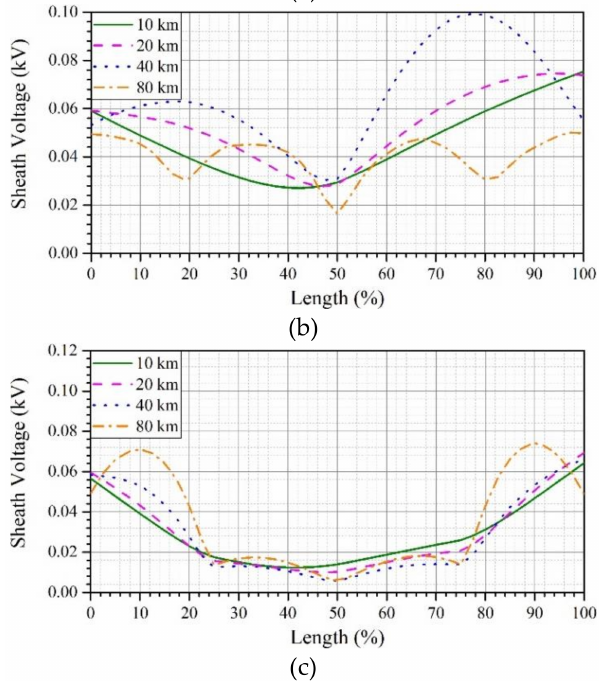
Figure 11. Steady state sheath voltage along length of 10, 20, 40 & 80 km cable ( a ) Terminal Grounded